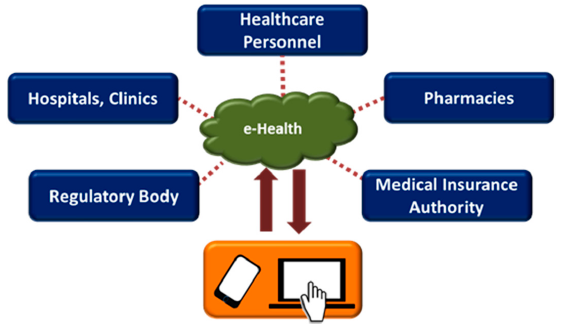
Figure 2. E-Health Infrastructure.